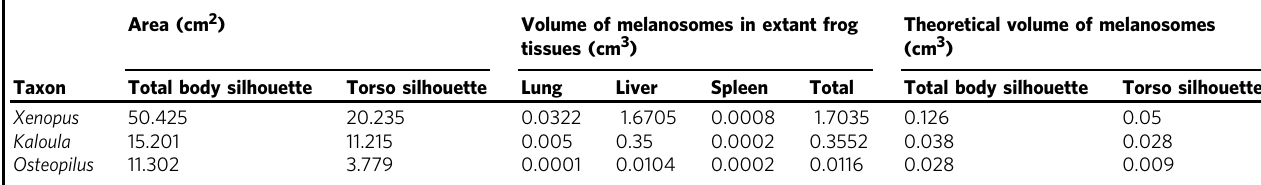
Table 2 Abundance and volume of melanosomes in extant Xenopus , Kaloula and Osteopilus Area (cm 2